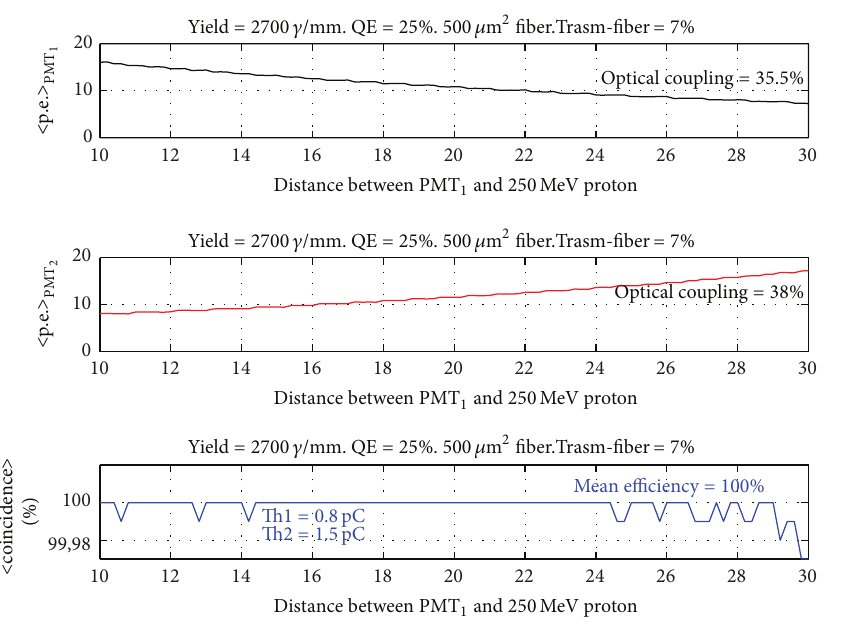
Figure 15: Simulation similar to Figure 14 adopting photomultipliers with a QE of